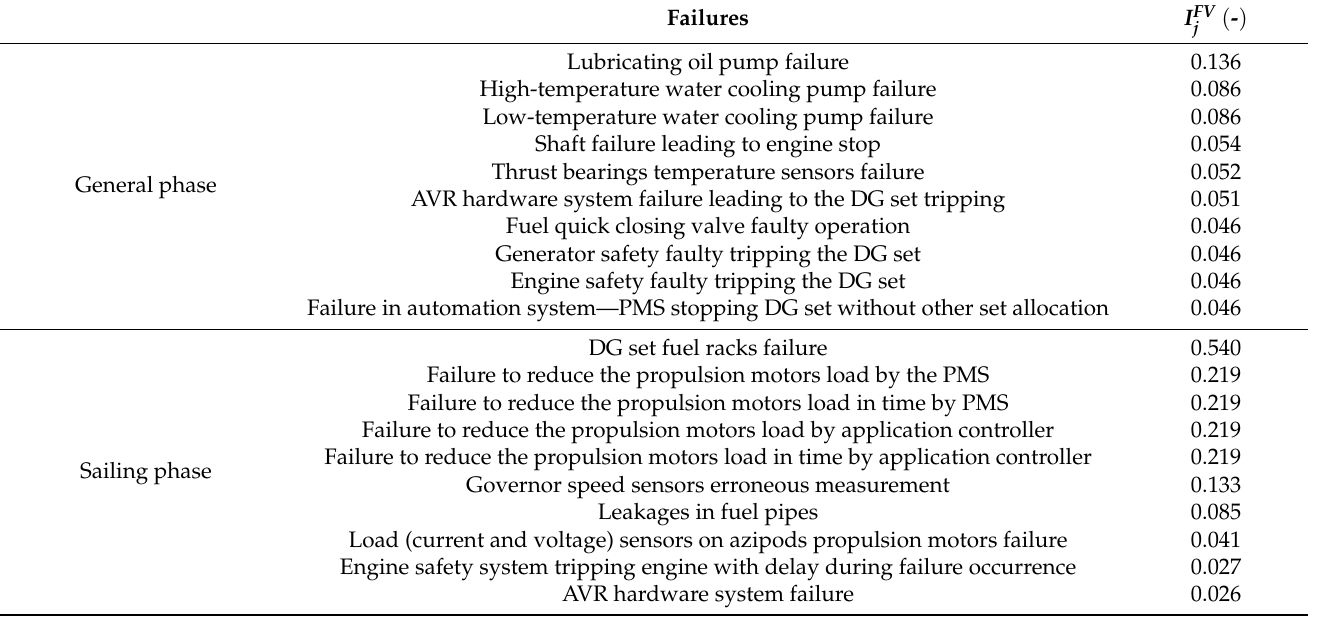
Table 7. Top critical failures in the investigated system.